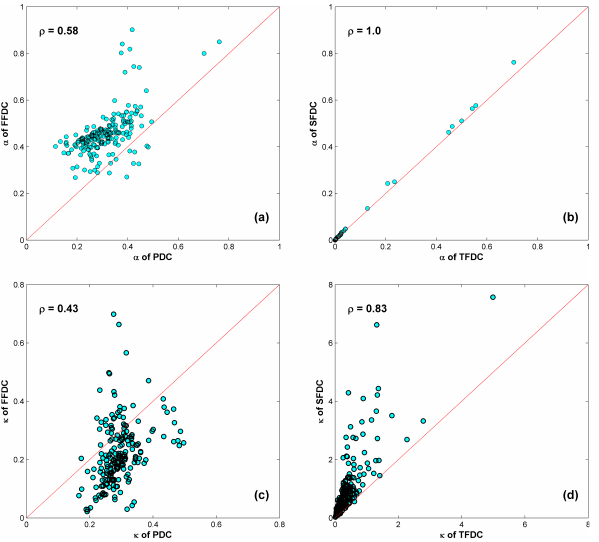
Fig. 7. Cross-correlation of parameters κ and α of the mixed gamma distribution between PDC and FFDC ( a and c ), and between TFDC and SFDC ( b and d